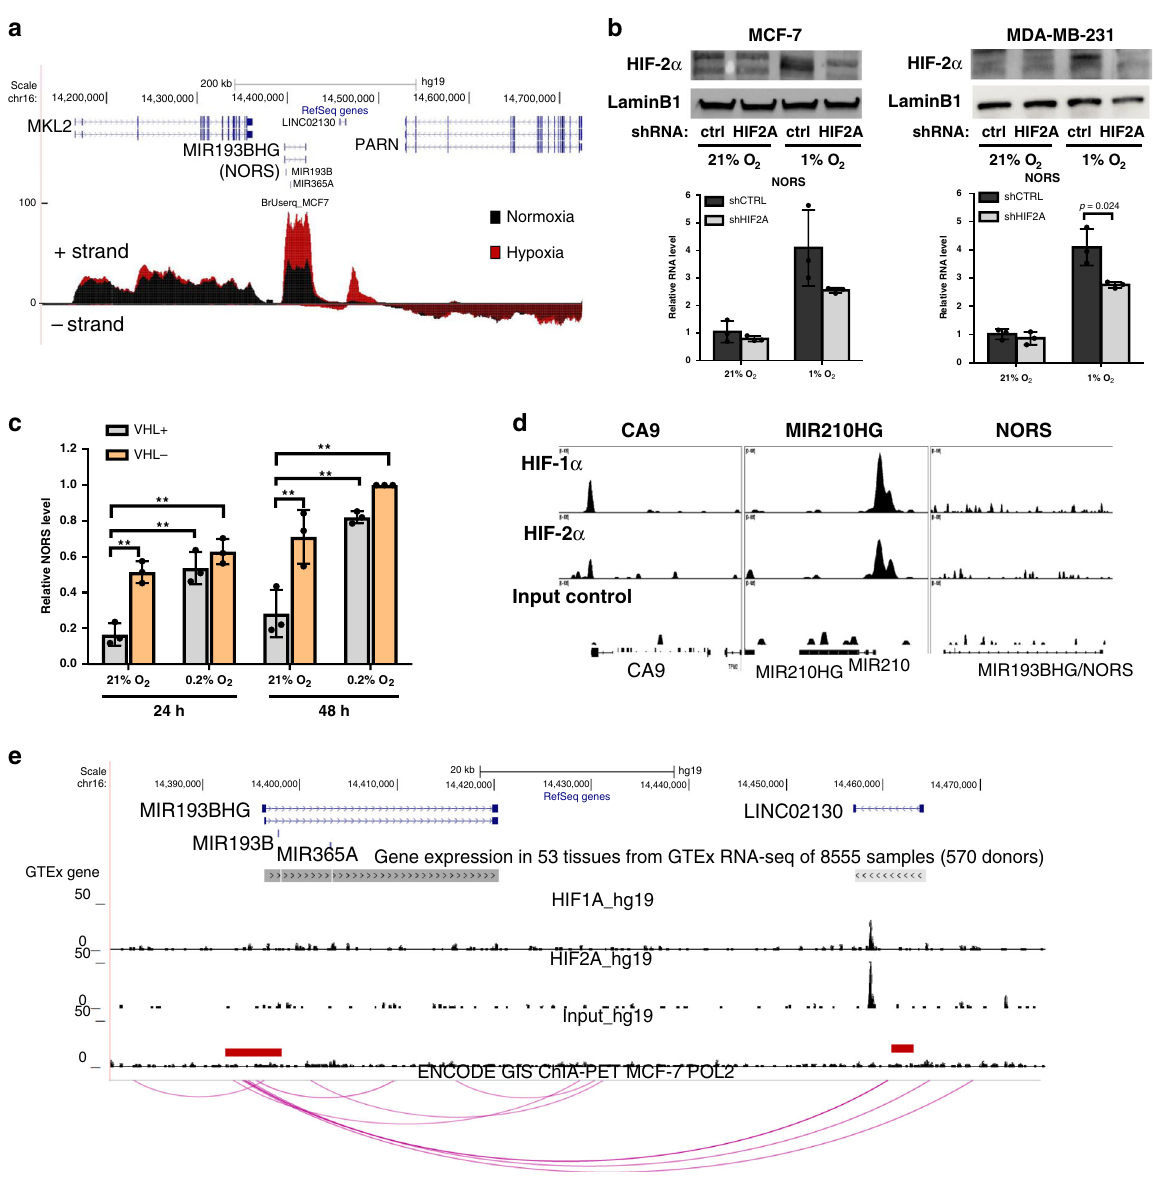
Fig. 2 lincNORS expression is regulated by HIF-2 α . a UCSC genome browser view of newly synthesized RNA at the lincNORS(MIR193BHG) locus in MCF- 7 cells cultured under 21% O 2 (black) and 1% O 2 (red) detected by Bru-seq. Strand-speci fi city was represented by positive/negative scales. b qPCR analysis of lincNORS expression in MCF-7 and MDA-MB-231 cells with stable HIF-2 α knockdown. MCF-7 and MDA-MB-231 cells stably expressing HIF-2 α shRNA or control shRNA were cultured in 21% O 2 or 1% O 2 for 48 h. HIF-2 α knockdown was con fi rmed by western blot and representative results are shown. Data are shown as mean ± SD from three biological replicates (* p < 0.05, two-sided Student ’ s t -test). c qPCR analysis of lincNORS expression in 786-O cells expressing empty vector (VHL − ) or reconstituted wild type VHL (VHL + ) cultured in 21% O 2 or 1% O 2 . Data are shown as mean ± SD from three biological replicates (** p < 0.01, two-way ANOVA followed by Tukey ’ s test). d UCSC genome browser view of HIF-1 α and HIF-2 α binding in lincNORS, CA9, and MIR210HG promoters in MCF-7 (ChIP-seq GSE28352). e UCSC genome browser view displaying HIF-1 α and HIF-2 α binding around lincNORS locus (MCF-7: ChIP-seq GSE28352), and chromatin interaction between lincNORS promoter and the HIF binding region within LINC02130 (MCF-7: RNA PolII_ChIA-PET